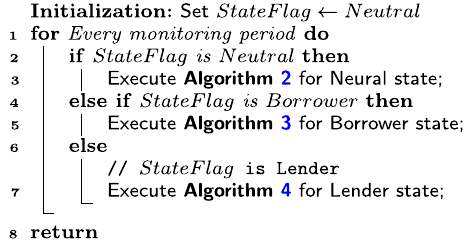
Algorithm 1 Controller AlgorithmA PM needs to have